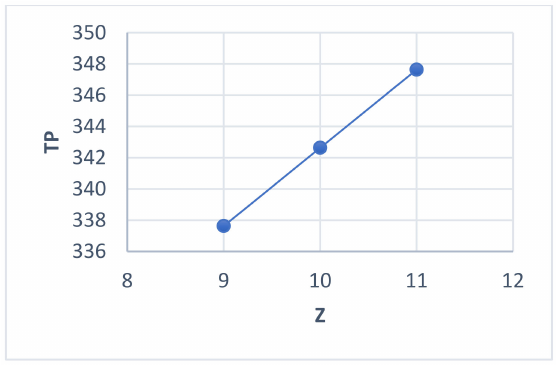
Figure 9. Impact of increasing Z on total profit.